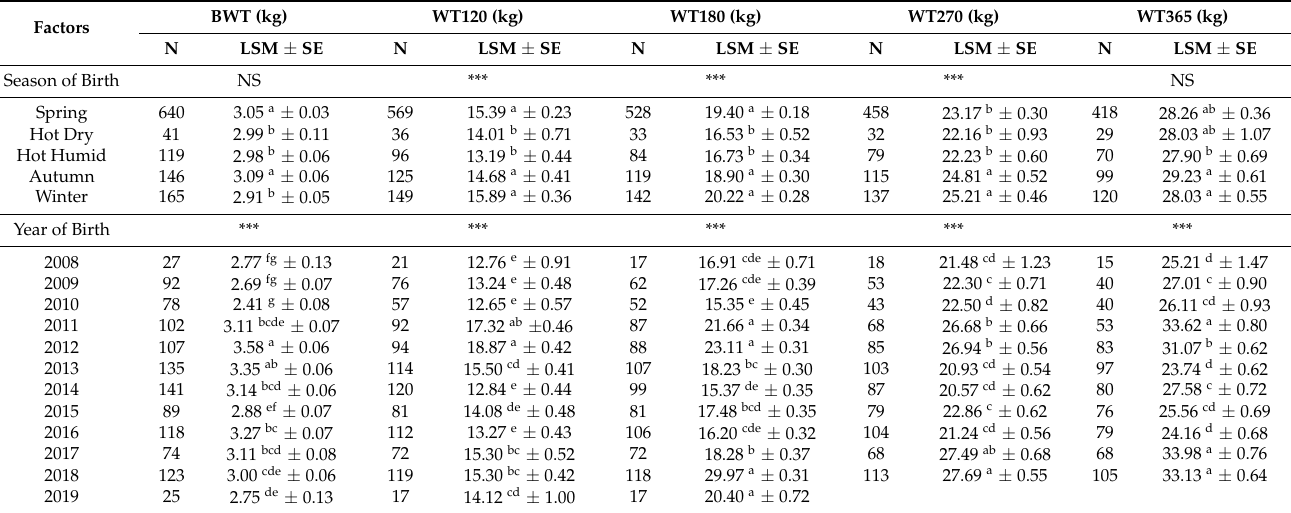
Table 2. Effect of season and year of birth on growth traits of Lohi sheep.